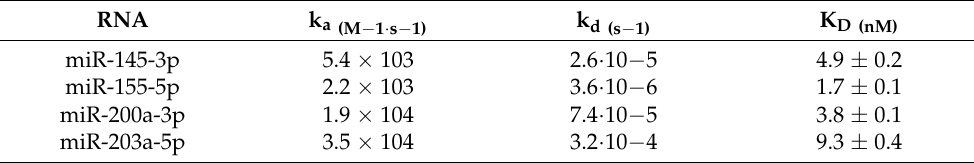
Table 3. Kinetic analysis of the interaction of NUCB1 with microRNA.